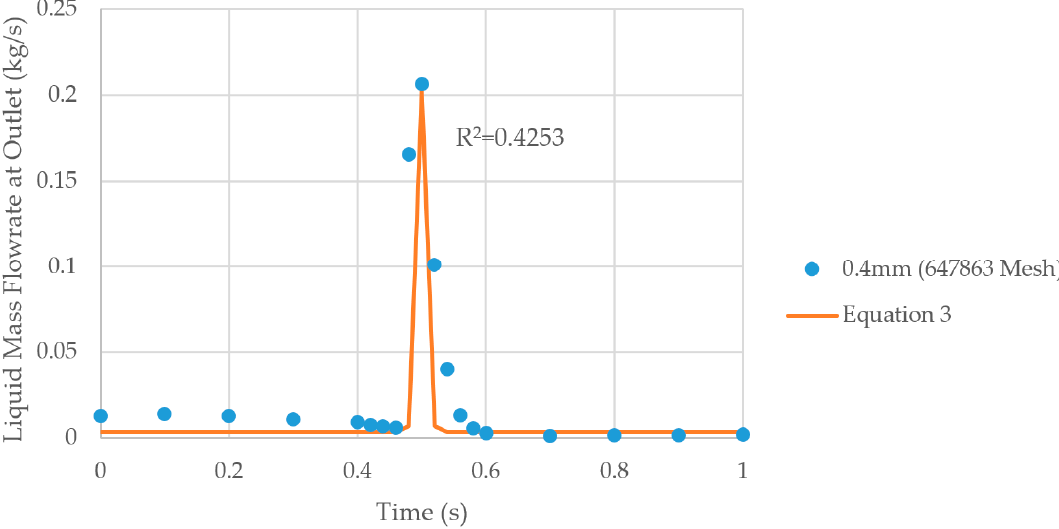
Figure 13. Comparison of ANSYS Fluent data with Equation (3) (normal distribution equation).